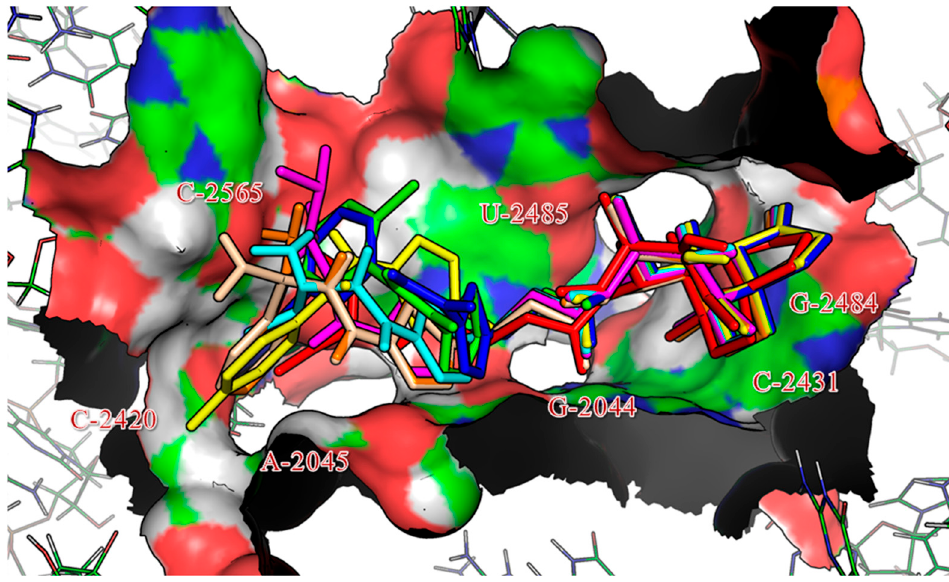
Figure 2. Superimposition of native ligand, tiamulin (colored by red) and the best conformations of 5a (green), 5b (blue), 5c (yellow), 6a (magenta), 6b (cyan), 6c (orange) and 6d (wheat) docked to the binding pocket of ribosome